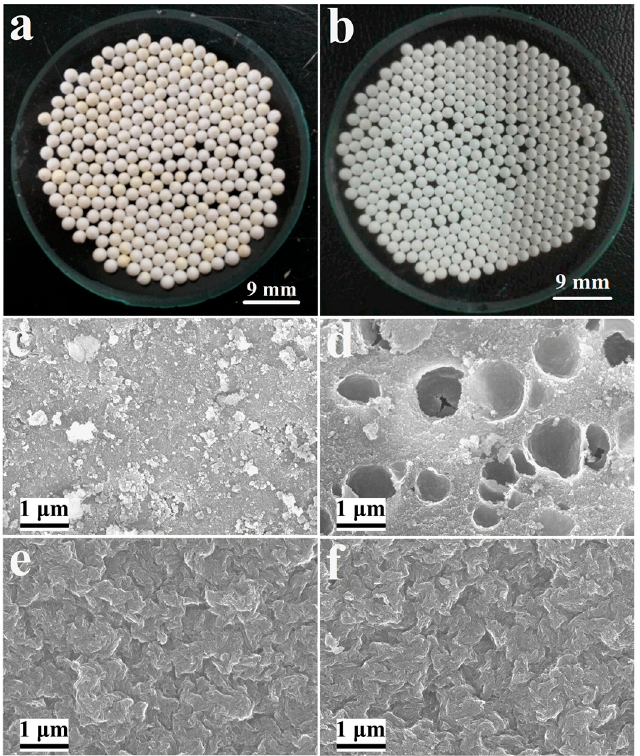
Figure 4. Photograph of Al 2 O 3 -I ( a ) and Al 2 O 3 -S ( b ); SEM image of Al 2 O 3 -S ( c , d ) and Al 2 O 3 -I ( e , f ).